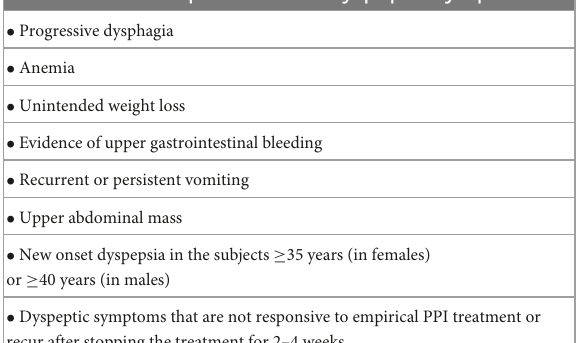
Alarm features in patients with dyspeptic